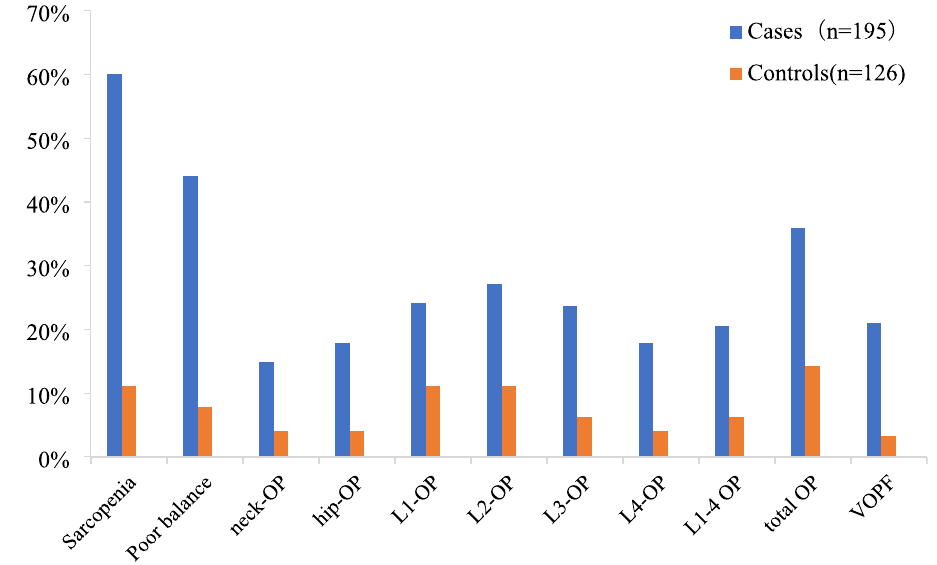
Figure 1. Comparison of sarcopenia, poor balance, and OP between female RA patients and controls.